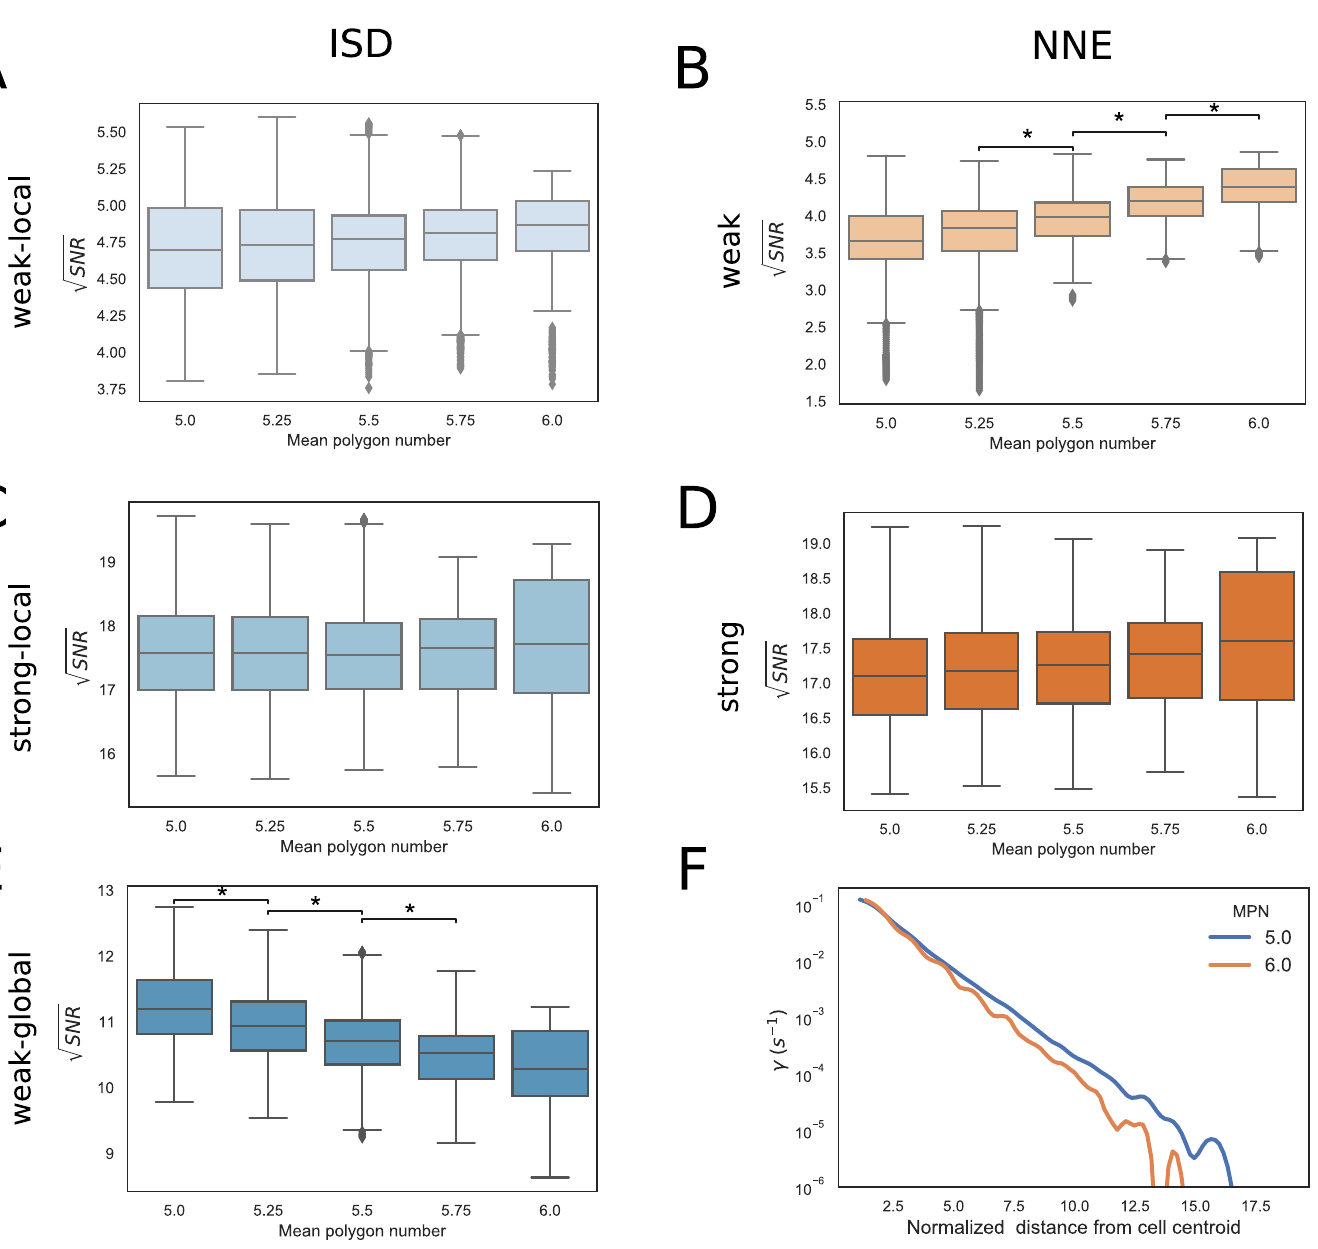
ffiffiffiffiffiffiffiffiffi p for configurations with different mean polygon number and 127 cells. The SNR = 10.0 s − 1 . E: Weak-global (ISD) communication: NNE = 7.1 μm in the considered E